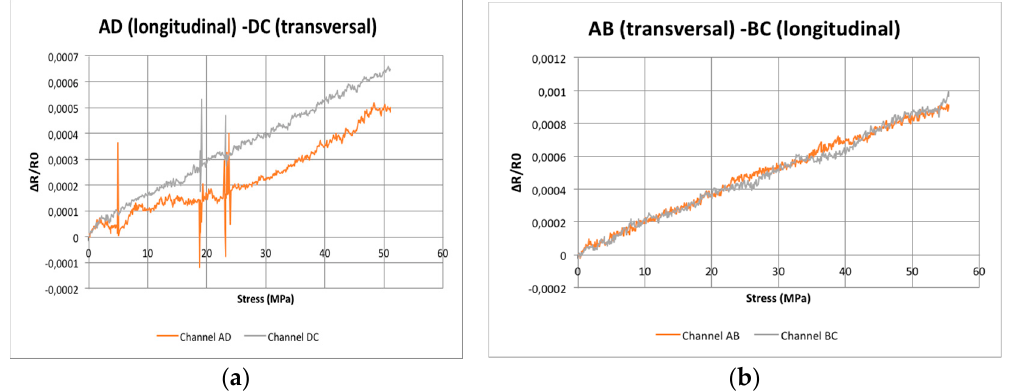
Figure 9. Longitudinal and transversal responses of carbon nanotube (CNT) sensors bonded to an aluminum plate and submitted to uniaxial loads. ( a ) Resistance changes for AD and DC paths. ( b ) Resitance changes for AB and BC paths.